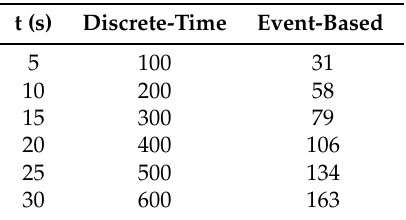
Table 2. RF channel utilization. Number of accumulated